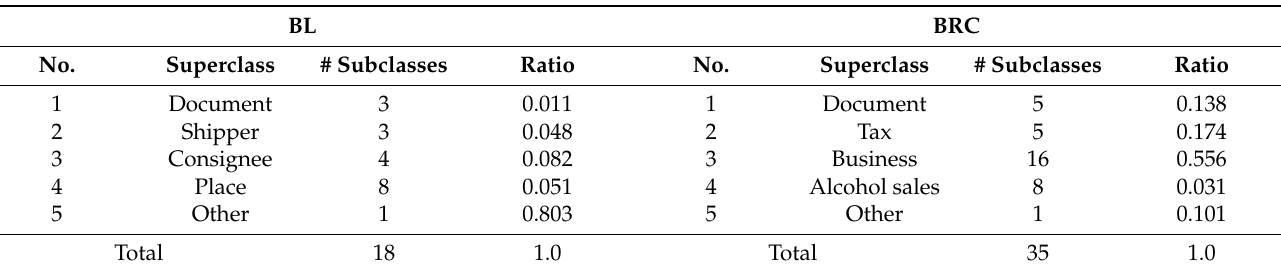
Table 1. Statistics of datasets for key information